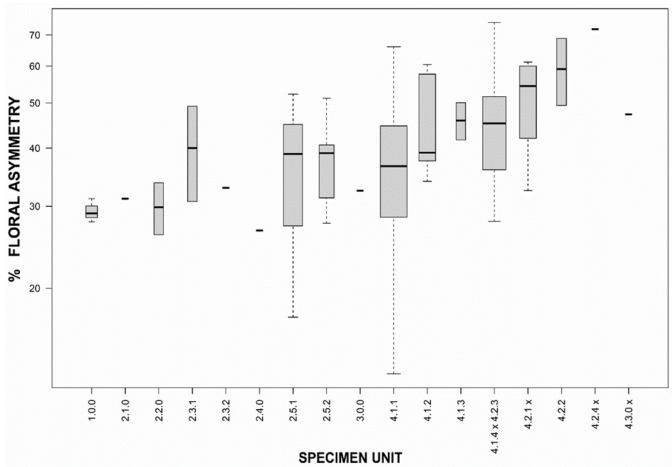
Figure 4. Boxplot: degree of floral asymmetry per specimen unit. Plot indicating the percentage asymmetry (the combination of the variables numbered as 27 and 32; Table S2) observed in flowers belonging to each of the studied genotypic